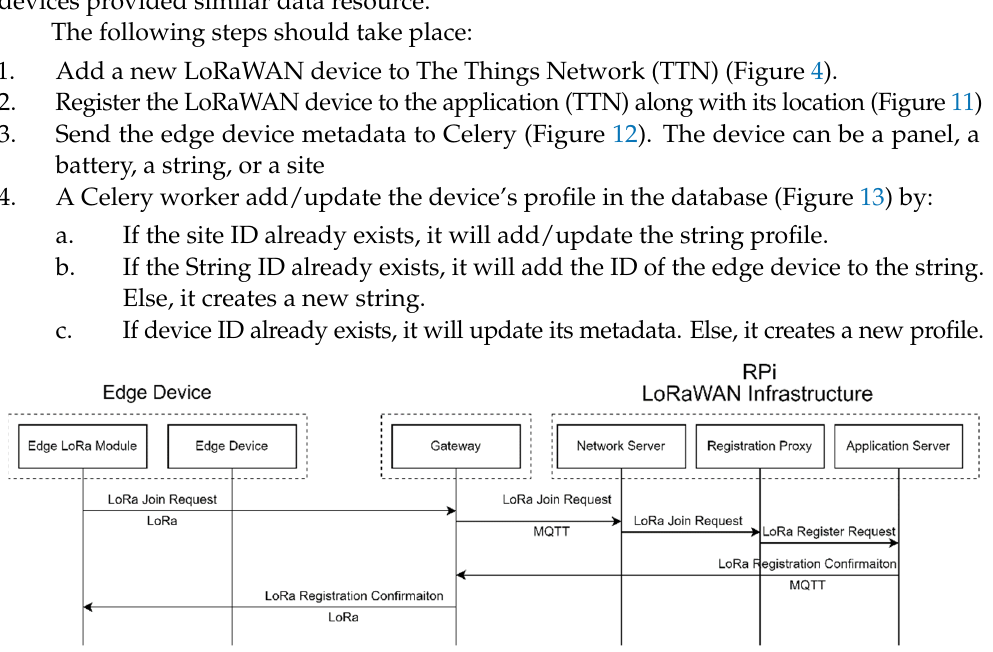
Figure 11. Sequence diagram for the first step of adding a new device.